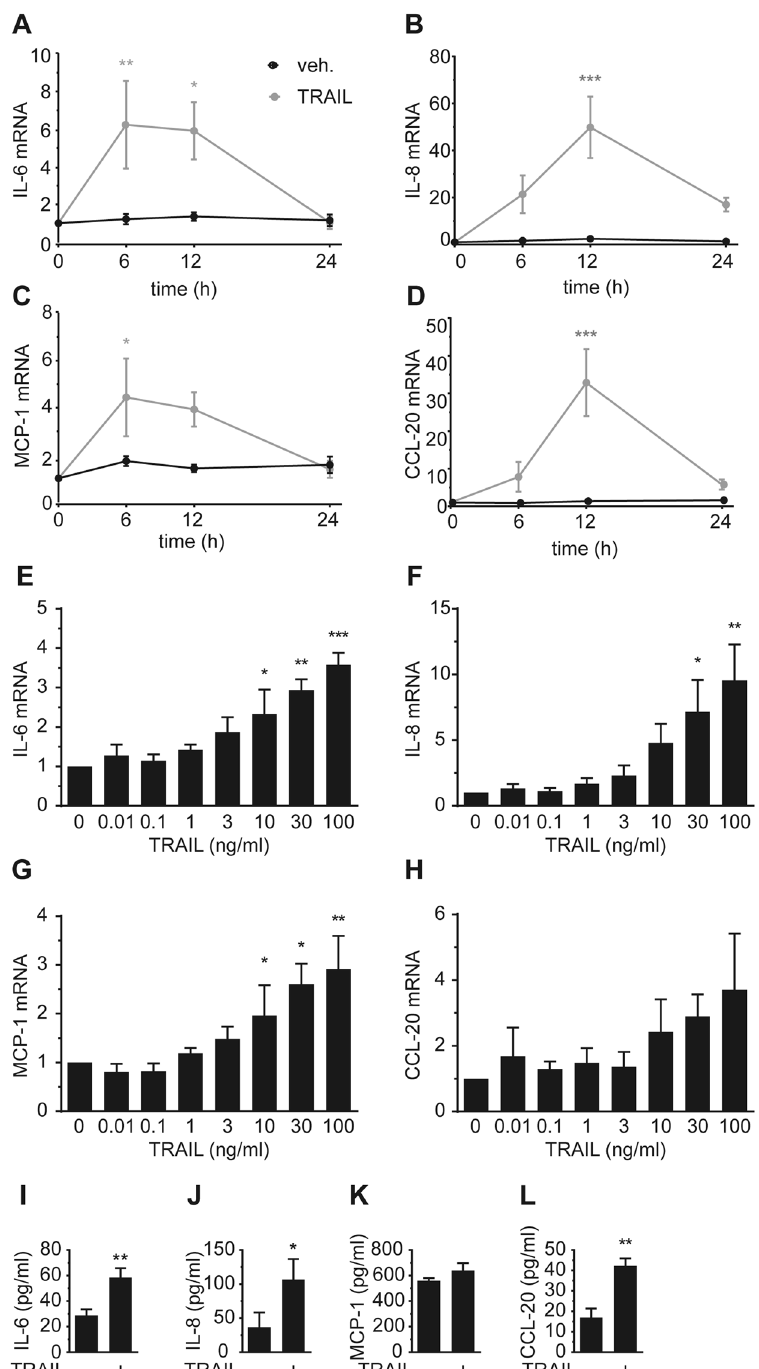
Figure 2. TRAIL regulates the production of cytokines and chemokines in a time- and dose-dependent manner. ( A – D ) SGBS adipocytes on day 14 of adipogenic differentiation were treated with TRAIL (30 ng/ ml) or vehicle for 6, 12 and 24 hours. The mRNA expression of IL-6 ( A ), IL-8 ( B ), MCP-1 ( C ) and CCL-20 ( D ) was analyzed by qPCR. The mRNA levels were normalized to HPRT. Depicted are the means and SEM of 4 independent experiments. Two-way ANOVA and Sidak’s multiple comparison were used to test for statistical significance. ( E – H ) SGBS adipocytes on day 14 of adipogenic differentiation were treated with increasing doses of TRAIL or vehicle for 6 hours. The mRNA expression of IL-6 ( E ), IL-8 ( F ), MCP-1 ( G ) and CCL-20 ( H ) was analyzed by qPCR. The mRNA levels were normalized to HPRT. Depicted are the means and SEM of 3 independent experiments. One-way ANOVA and Dunnett’s multiple comparison were used to test for statistical significance. ( I – L ) SGBS adipocytes on day 14 of adipogenic differentiation were treated with TRAIL (30 ng/ ml) or vehicle. After 24 hours, media supernatants were collected and IL-6 ( I ), IL-8 ( J ), MCP-1 ( K ) and CCL-20 ( L ) concentrations were determined by ELISA. Means and SEM of 3–7 independent experiments are shown. Unpaired Student’s t-tests were used to test for statistical significance. * p < 0.05, ** p < 0.01, *** p <